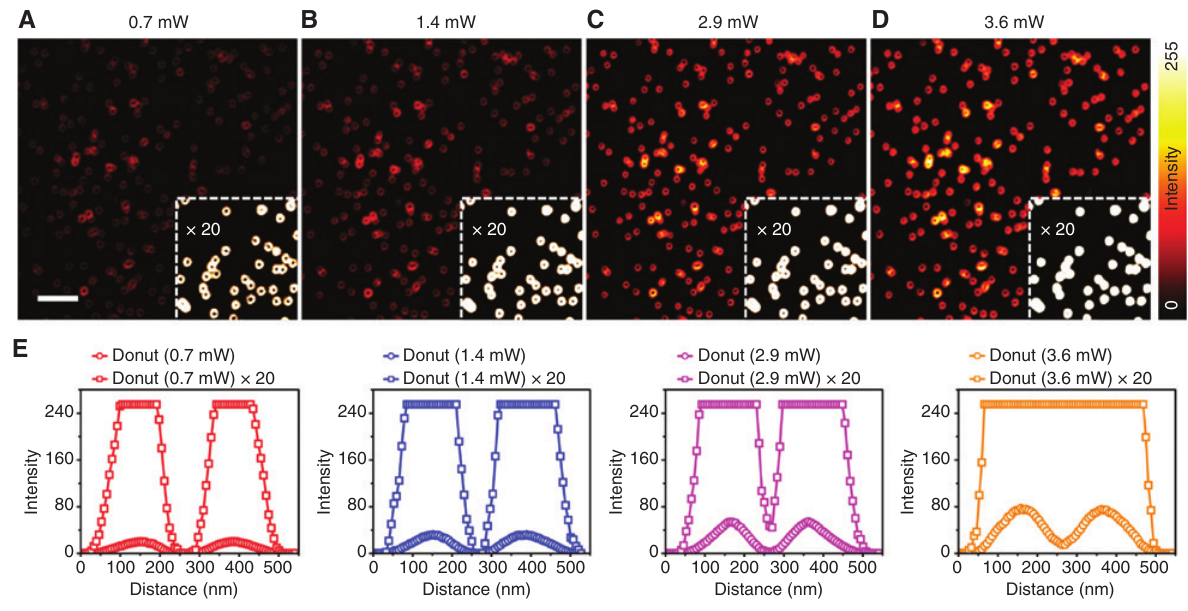
Figure 3: Digital enhancement of donut images. (A–D) Comparison between original and digitally enhanced donut images (bottom right, K = 20) at the depletion powers of 0.7, 1.4, 2.9, and 3.6 mW, respectively. Pixel size: 6.5 nm; FOV: 12.5 × 12.5 μ m 2 . Scale bar, 2 μ m. (E) Mean intensity profiles of 10 typical donuts in the original and digitally enhanced donut images in